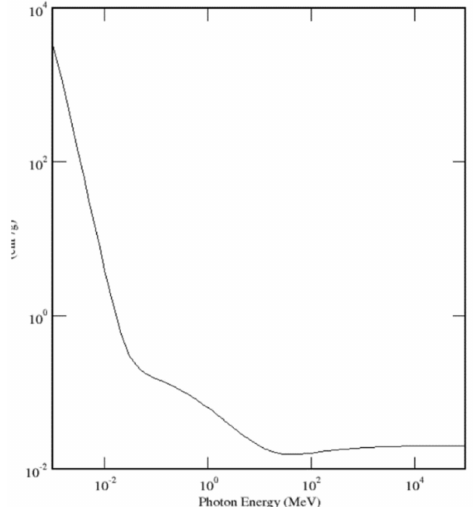
Figure 21. Nitrogen photon cross section.